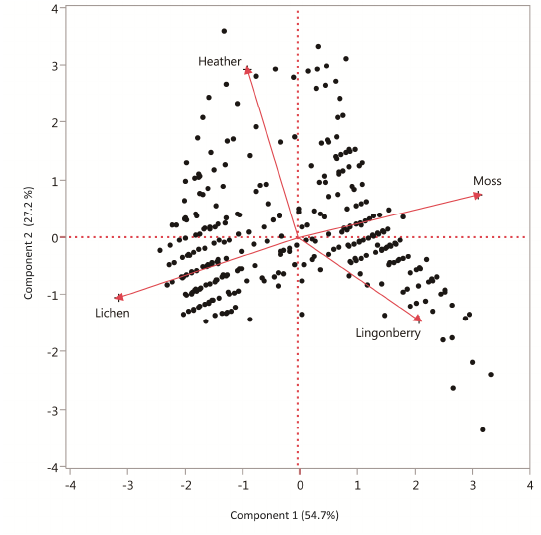
of the variation and is mainly related to the abundance of heather (+ loading on PC2). The